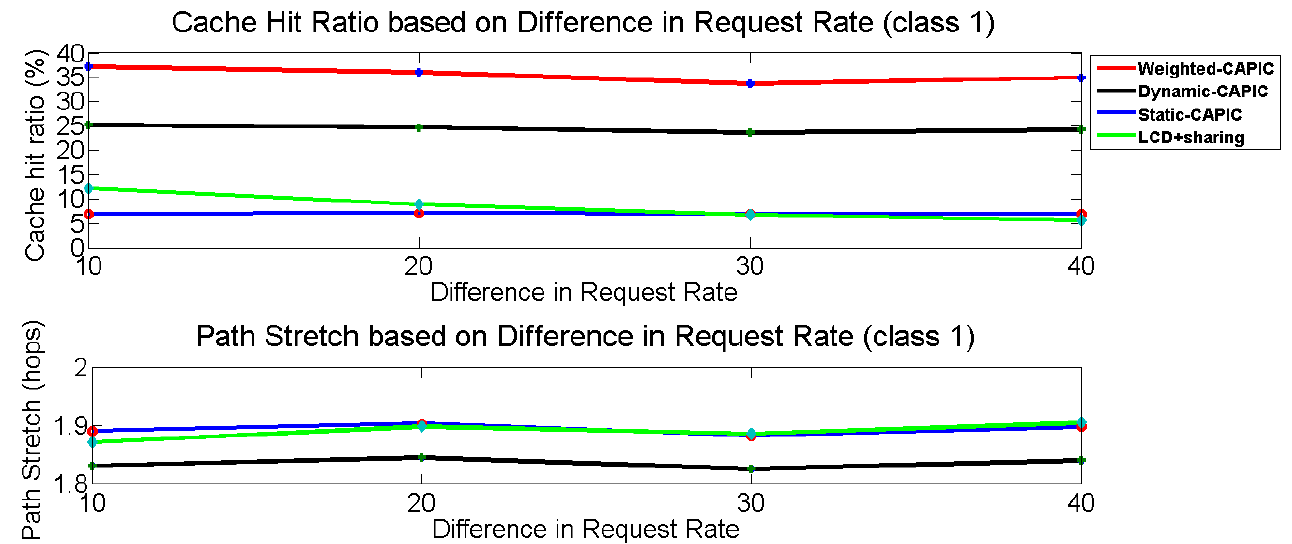
Figure 6. Cache hit ratio and path stretch of class 1 for various request rate